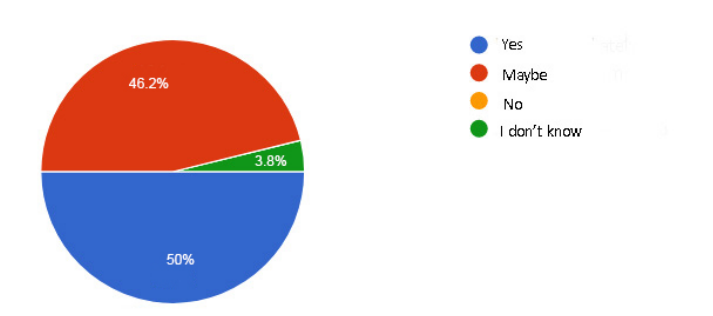
Figure 9. A total 38.5% are interested in the immediate replacement of conventional bins with smart ones and 57.7% are planning it in the medium term.